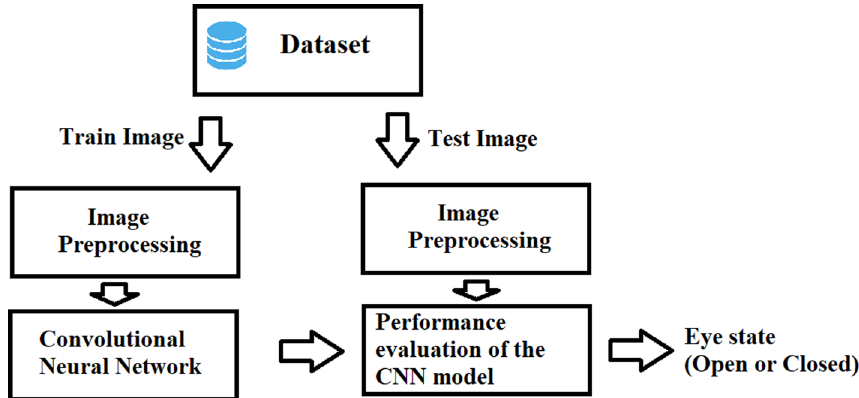
Fig. 1 Flow chart of the pro- posed